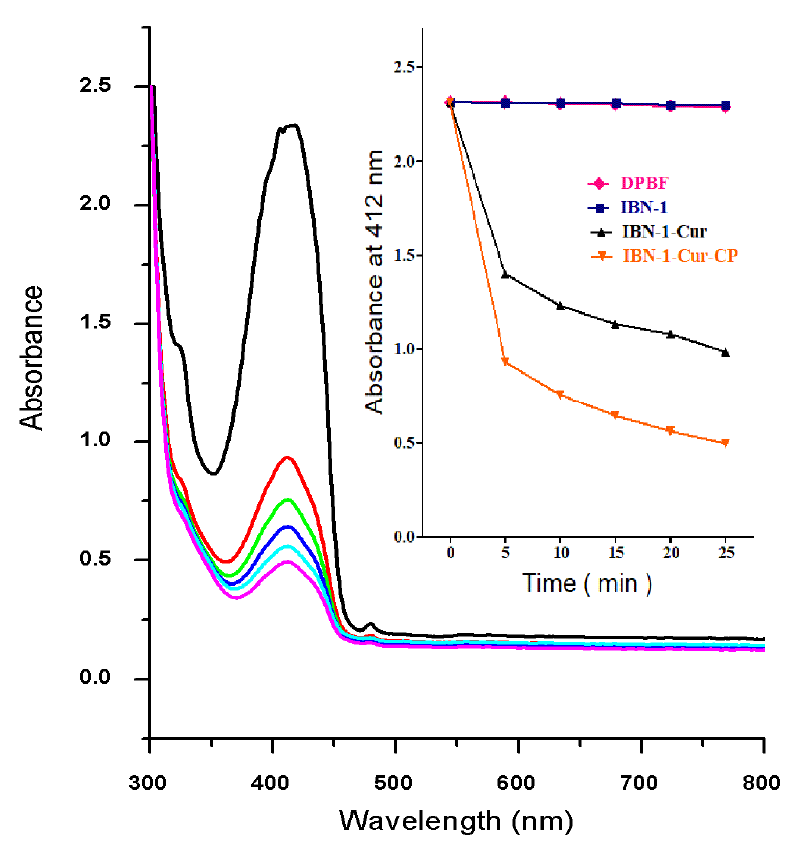
Figure 8. The photodegradation effect of DPBF through the generation of singlet oxygen species from IBN-1-Cur-CP exposed to light irradiation at different periods. The inset figure represents the time-dependent photobleaching of DPBF absorbance at 412 nm upon a light irradiation in the presence of IBN-1-Cur-CP at the time point of black-0, red-5, green-10, blue-15, cyan-20, and magenta-25 min.